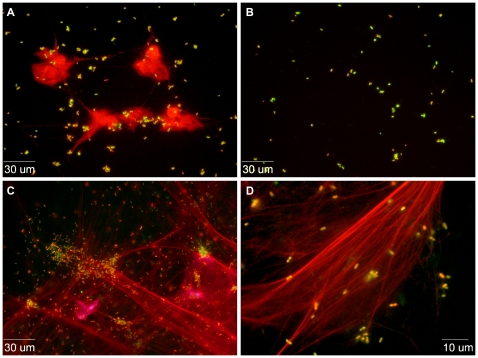
NET formation and binding of P. aeruginosa by nonadherent neutrophils.
Panels A and B: Bacterial cells of strain PAO1 labeled with polymyxin B-BODIPY were incubated with isolated human neutrophils (MOI of 10) for 2 hours with (Panel B) or without (Panel A) DNase. NETs were then stained with the cell-impermeant DNA binding dye, Sytox Orange. In the presence of DNase, NETs are seen to be completely degraded. Panels C and D present the results of a similar experiment performed at a higher ratio of bacteria to neutrophils (MOI of 100), to highlight the physical association of bacteria with NETs.